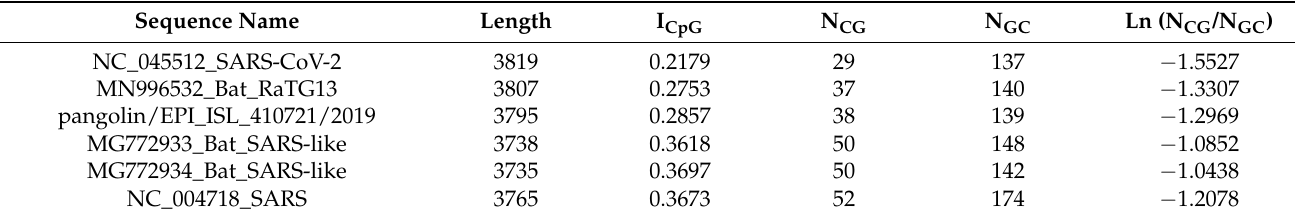
Table 1. Genomic CpG deficiency in the coding sequence encoding the spike proteins, measured by two indices: I CpG = (P C *P G /P CG ) and ln (N CG /N GC ). The expectation of no CpG deficiency is 1 for I CpG and 0 for ln (N CG /N GC